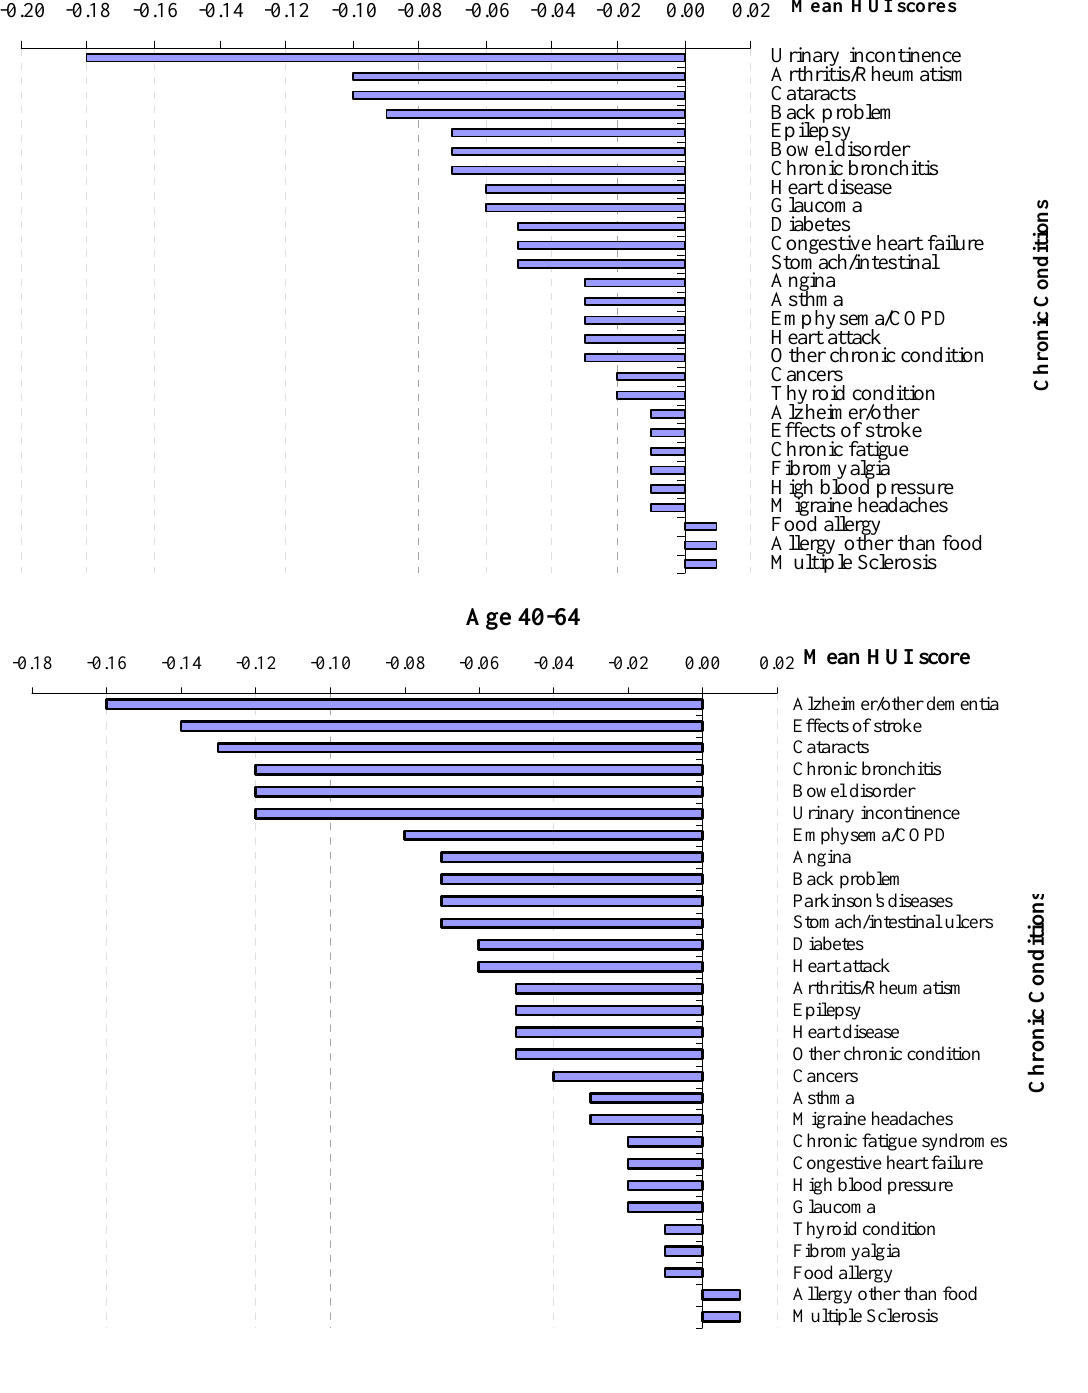
FIGURE 2 . Impact of selected chronic conditions on HRQL by age group and household population aged 12 and over. CCHS Data,